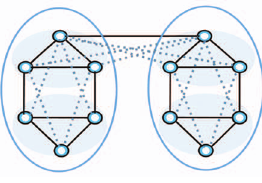
Figure 1. Completing triangles followed by clustering aggre- gate shattered communities. Dashed lines show different possibil- ities for completing triangles.